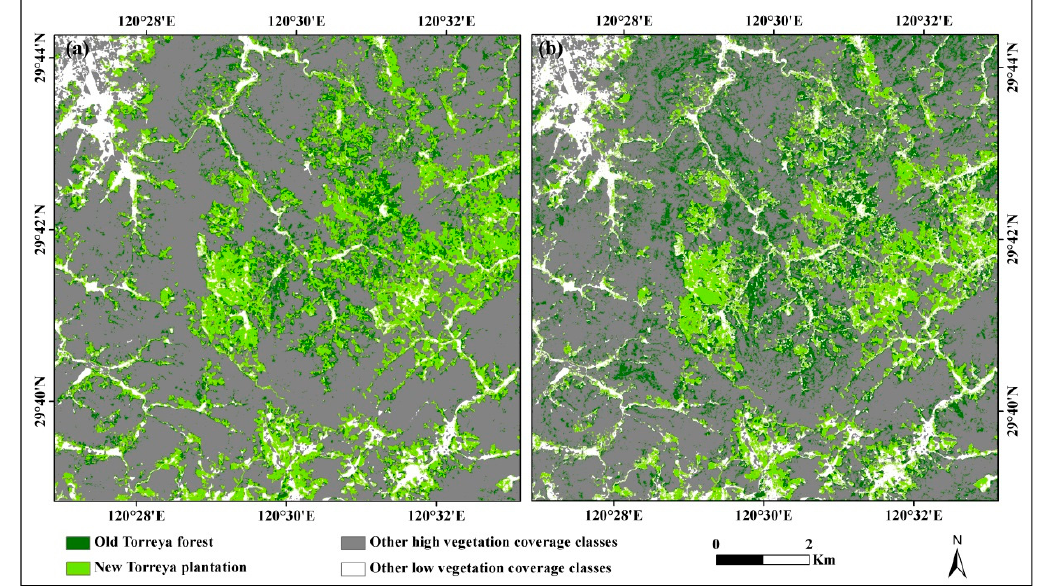
Figure 7. Spatial distribution of old Torreya forests and new Torreya plantations using ( a ) expert rules based approach and ( b ) maximum likelihood classifier based on multi-source data.